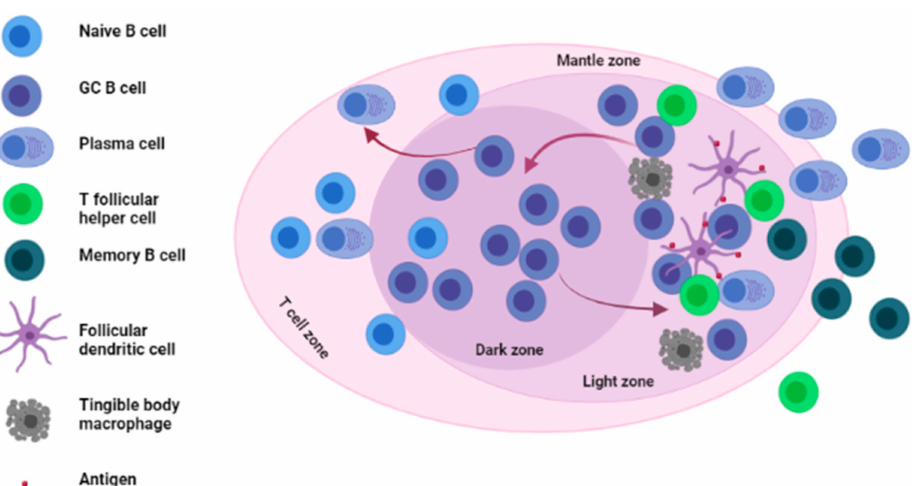
Figure 1. Architecture and main cellular components of the germinal center. The germinal center is mainly divided into two zones; the Dark zone (DZ) where GC B cells undergo somatic hypermutation (SHM) of their immunoglobulin (Ig) genes and the light zone (LZ) where GC B cells interact with antigens presented to them by FDCs as well as T follicular helper cells (Tfh). GC: germinal center, FDCs: follicular dendritic